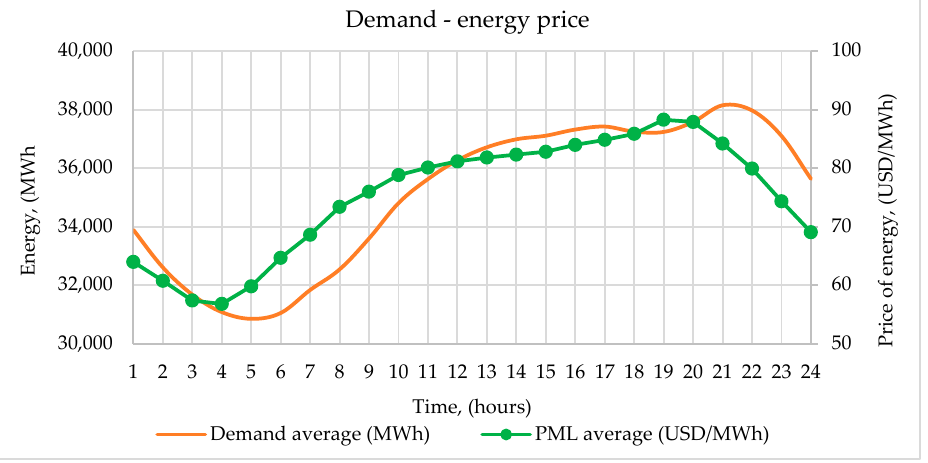
Figure 2. Average comparison between demand and energy price. Own source with CENACE data, 2021.